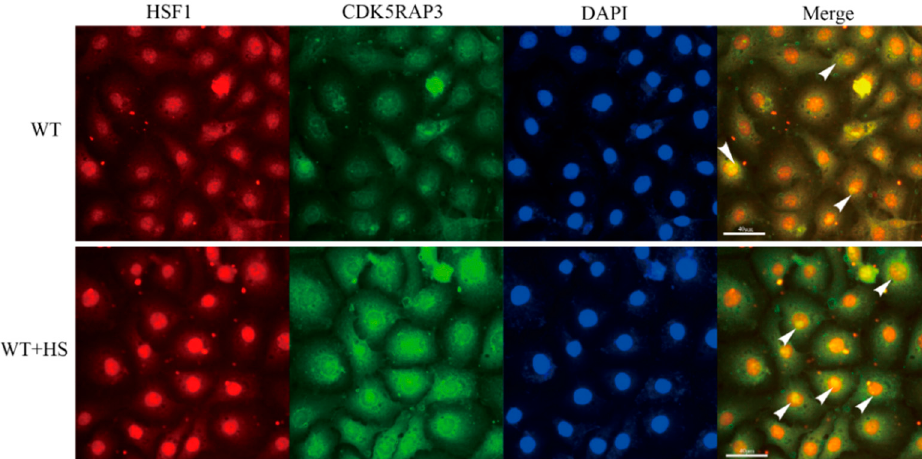
Figure 8. DAPI is the staining of the nucleus, and the nucleus is blue light. The CDK5RAP3 shows a green light. HSF1 shows a red light. The yellow light indicates that there is a binding between CDK5RAP3 and HSF1, and the binding site is indicated by a white arrow. Merge is a synthesis diagram of the cytoplasm and nucleus. The scale bart “40 μ m” is indicated by a white straight line in Merge.